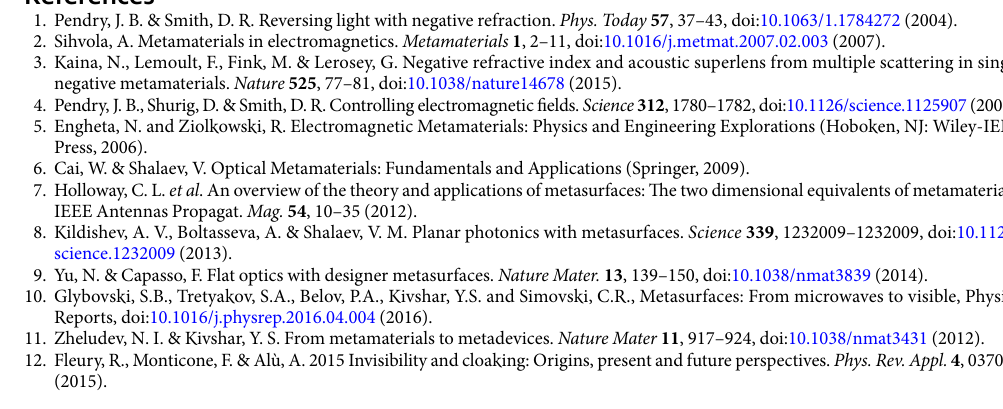
3D EM simulations were performed using finite integration technique (FIT) software (CST Microwave Studio, Darmstadt, Germany). The RF transmit field is defined as the left circularly polarized transverse field B 1 + = ( B 1 x + B 1 y )/ 2 and the receive field as B 1 − = ( B 1x − B 1y )/ 2 . The magnitude of the RF transmit field defines the excitation tip angle θ applied to the spins in the excited volume, θ = γ B 1 + τ where γ is the gyromagnetic ratio and τ is the pulse duration. The signal-to-noise (SNR) of the image is proportional to sin( θ ) ∙ B 1 − * / √ P 37 , where P is the accepted power of the coil. All RF transmit (B 1 + ) maps were normalized to an accepted power of 1 Watt. The simulation setup included a 16-rung high pass quadrature birdcage coil (inner diameter 30 cm; rung length 18 cm), corresponding to the transmit coil used for experimental measurements. For in vivo simulations the coil was loaded with the Virtual family model”Ella” dataset which consists of 76 different tissues with assigned values of permittivity and conductivity 38 . The mesh resolution was 1.0 × 1.0 × 1.0 mm 3 . The phantom setup simulations used a rectangular shape oil phantom with either a flat metasurface structure or a high permittivity pad placed on top. In the in vivo simulations, the metasurface structure was curved to best fit the shape of the head. To account for the actual structure of the metasurface, in addition to the high permittivity layer, the simulation also included an interface between the copper strips and the dielectric layer of 0.5 mm thickness with ε r = 1. Phantom and in-vivo images of a volunteer were acquired on a Philips Achieva 7 T MRI system. All methods were carried out in accordance with Leiden University Medical Center guidelines and regulations. All experimental protocols were approved by the the Leiden University Medical Centre Medical Ethics Committee. In vivo images and spectroscopy of the brain were acquired from healthy volunteers after informed consent was obtained, in accord- ance with the guidelines of the Leiden University Medical Centre Medical Ethics Committee. Phantom experi- ments were performed using a quadrature head birdcage coil (Nova Medical NM-008A-7P) for both transmit and receive. In-vivo brain imaging was acquired using a quadrature birdcage for RF transmit and close fitting 32-channel receive head coil (Nova Medical NMSC-025-32-7P). The images included a standard gradient-echo sequence that was used for SNR estimation and B 1 + maps images were acquired using the DREAM 39 sequence. The following scan parameters were used for gradient echo sequence: FOV 24 × 24 cm 2 , spatial resolution 1.5 × 1.5 × 5.0 mm 3 , TR/TE 10/3.4 ms, flip angle 5°; and for DREAM sequence: FOV 24 × 24 cm 2 , spatial resolution 2.5 × 2.5 × 5.0 mm 3 , TR/